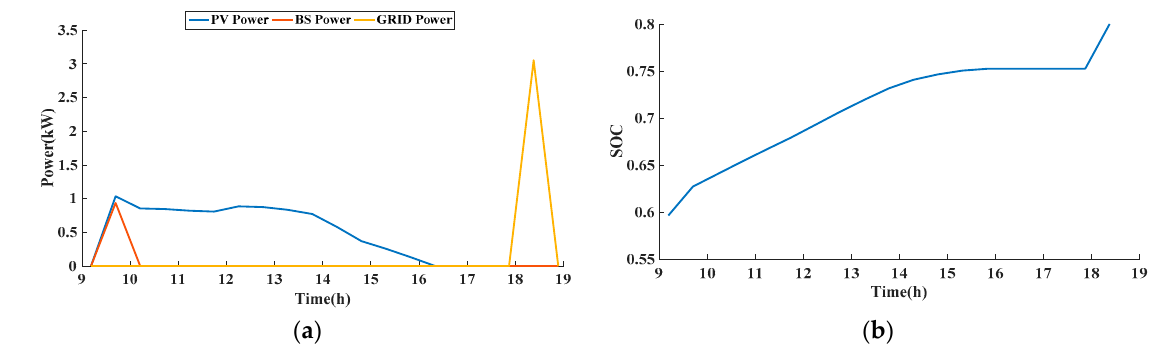
Figure 18. Typical charging curve of EV. ( a ) charging power; ( b ) SOC.